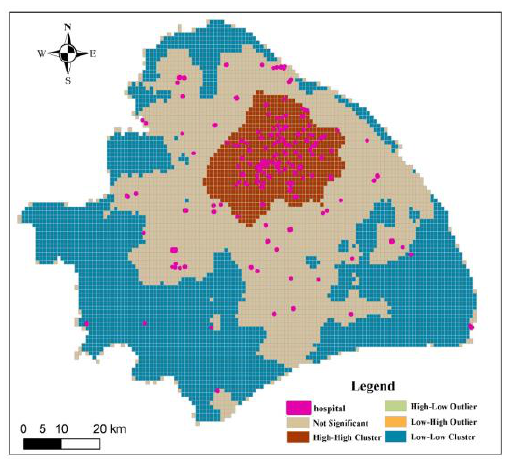
Figure 12. The spatial distribution of local